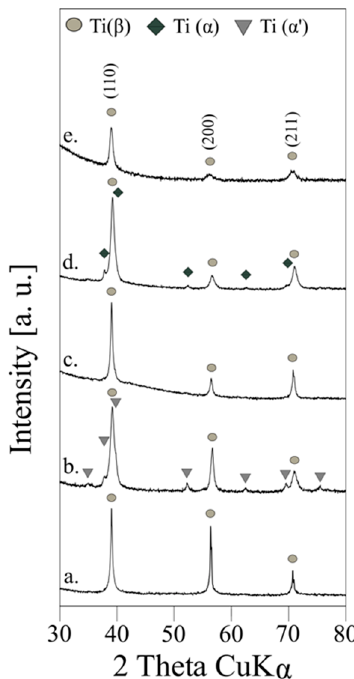
Figure 1. XRD spectra of Ti23Mo alloys obtained by different processing approaches: Arc melted ( a ), arc melted and annealed at 800 °C/24 h ( b ), MA for 48 h and: hot pressed at 800 °C/5 min ( c ), cold-pressed and sintered at 800 °C/0.5 h ( d ) and cold-pressed with NH 4 HCO 3 and sintered at 1150 °C/10 h ( e ).